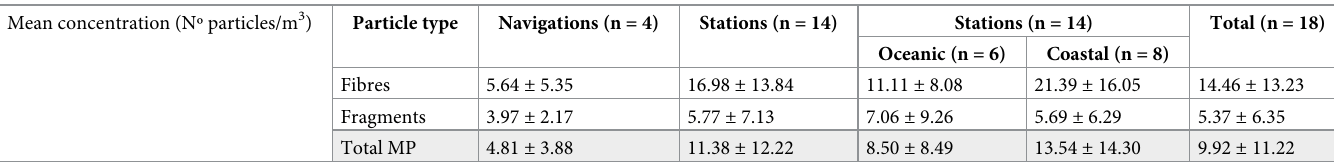
Table 3. Microplastic particle concentrations expressed in number of particles/m 3 .